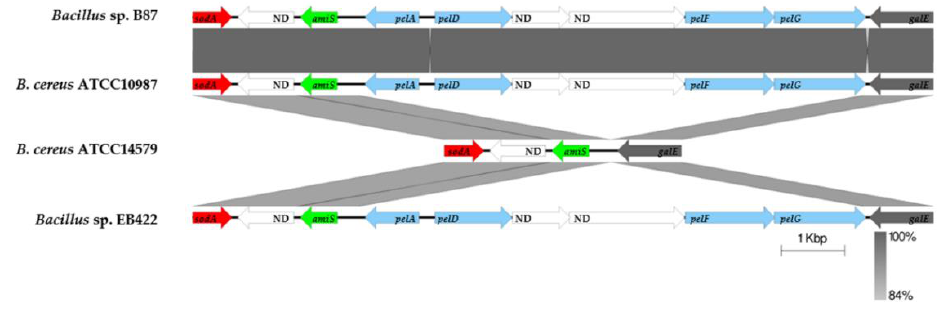
Figure 5. Genetic organization of the pelDEA DA FG operon. The pelDEA DA FG operons were compared using the Easyfig tool with homologous clusters found in related species of the genus Bacillus . Arrows indicate the transcription direction of each CDS with different colors (red, sodA ; green, amiS ; light blue, pel ; grey, galE ; white, unknown function (ND)). The shade of gray indicates the degree of nucleotide sequence homology (%) according to BLASTN.